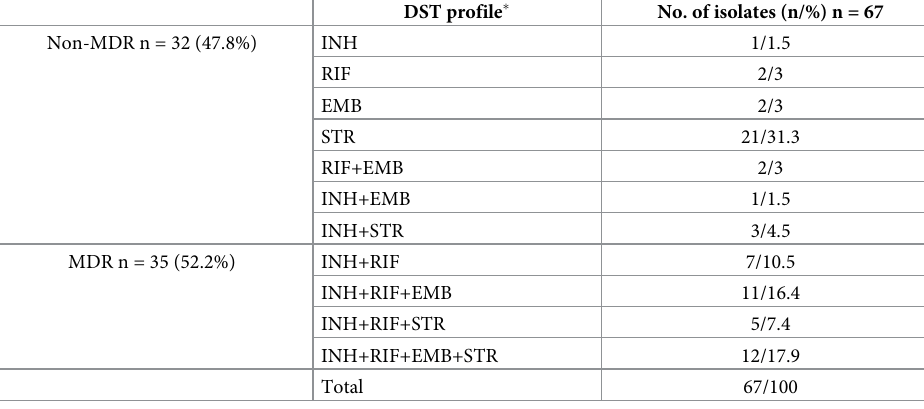
Table 1. Drug susceptibility profiles of 67 isolates under the study.